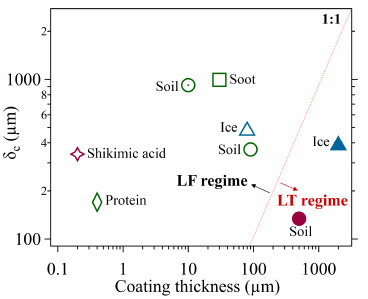
Figure 6. Representative coating thickness in previous coated-wall flow tube studies versus the calculated critical height δ c (based on their experimentally adopted d and V avg ). The color of the symbols indicates the different types of carrier gases employed: synthetic air (green symbols), nitrogen (purple), and helium (blue). Refer- ences for the coatings summarized here are diamond (Shiraiwa et al., 2011), square (Monge et al., 2010), open circle (Donaldson et al., 2014a, b), open circle with center (Wang et al., 2012), solid cir- cle (Li et al., 2016), star (Steimer et al., 2015), solid triangle (Mc- Neill et al., 2006), and open triangle (Petitjean et al., 2009). LF and LT refer to laminar flow and local turbulence,